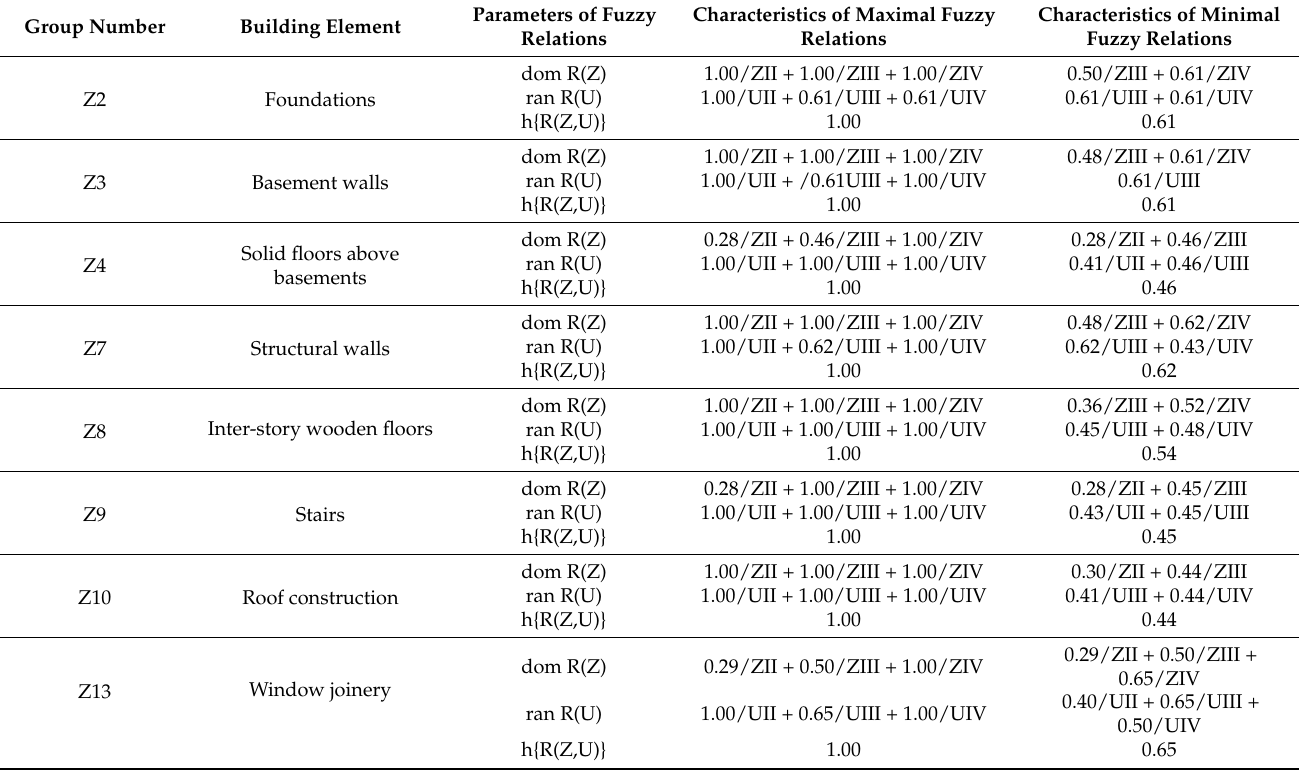
Table 4. The domain, scope, and height of fuzzy relations for 10 selected elements in the II, III, and IV maintenance class of a residential